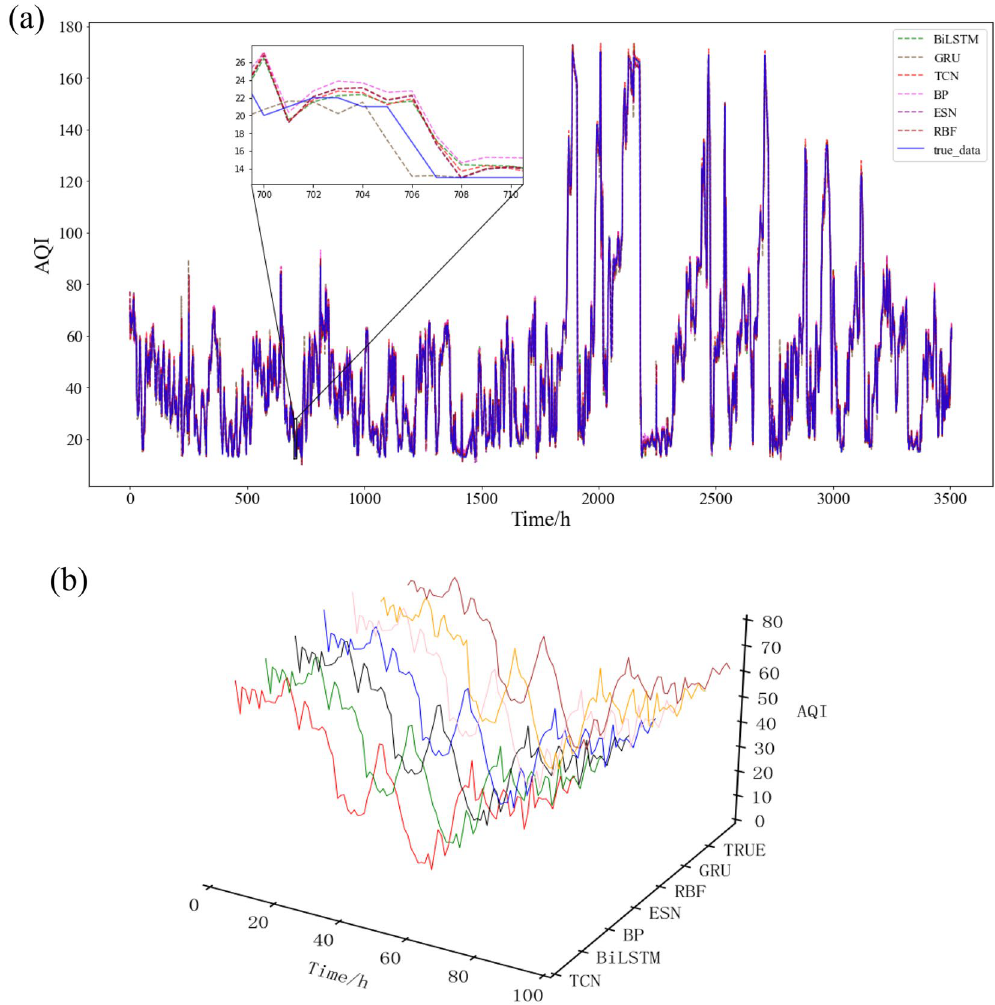
Figure 5. Prediction experimental results of a single model: ( a ) 2d plot; ( b ) 3d plot.